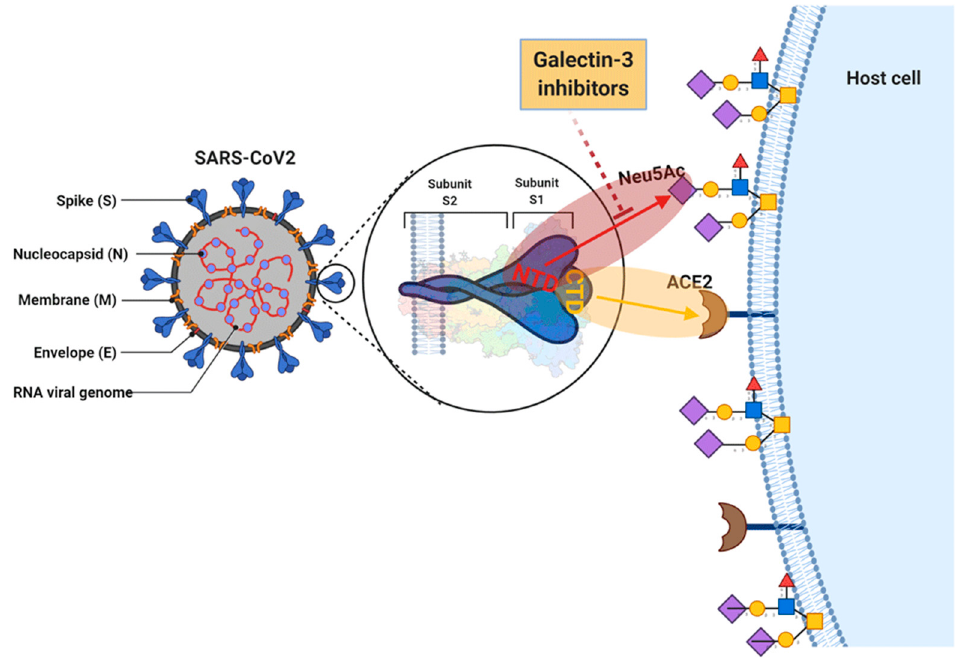
Figure 4. A dual attachment model for SARS-CoV2. This shows that a pocket in the NTD of SARS- CoV2 is capable of binding N -acetylneuraminic acid (Neu5Ac) [25] and strongly supports a dual attachment model for SARS-CoV2, where NTD-Neu5Ac interactions facilitate initial host cell recog- nition by the virus and stabilise its entry via ACE2 receptors. Adopted from [13] with